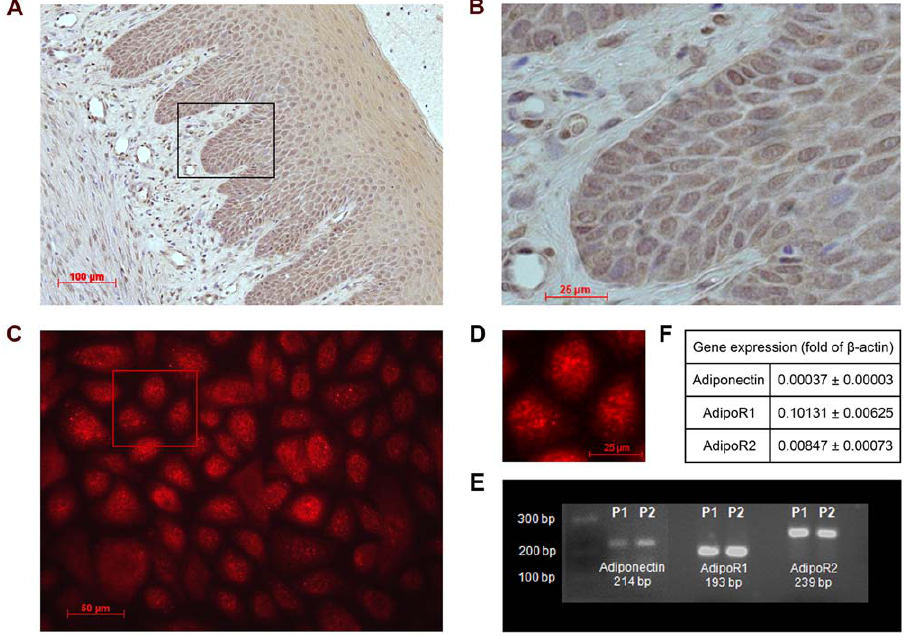
Figure 1. Adiponectin in gingival tissues and cultured oral epithelial cells. (A) Representative gingival tissue section from one out of 6 patients exhibiting adiponectin distribution assessed by immunohistochemistry with DAB-staining (brown color). (B) Higher magnification of the rectangular area shown in (A). (C) Immunofluorescence staining of adiponectin in cultured oral epithelial cells from one out of 6 patients. (D) Higher magnification of the rectangular area shown in (C). (E) Gene expression of adiponectin and its receptors AdipoR1 and AdipoR2 from oral epithelial cells of 2 patients (P1 and P2), as demonstrated by gel electrophoresis. (F) Gene expression of adiponectin and its receptors AdipoR1 and AdipoR2 from oral epithelial cells from 6 patients, as demonstrated by real-time